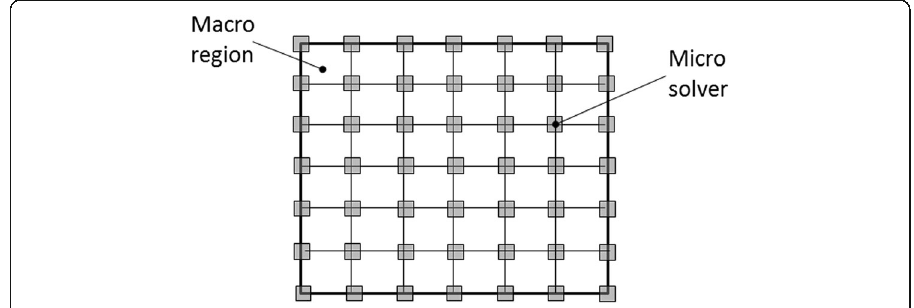
Fig. 2 Schematic of a typical heterogeneous multiscale method (HMM) model for fluid